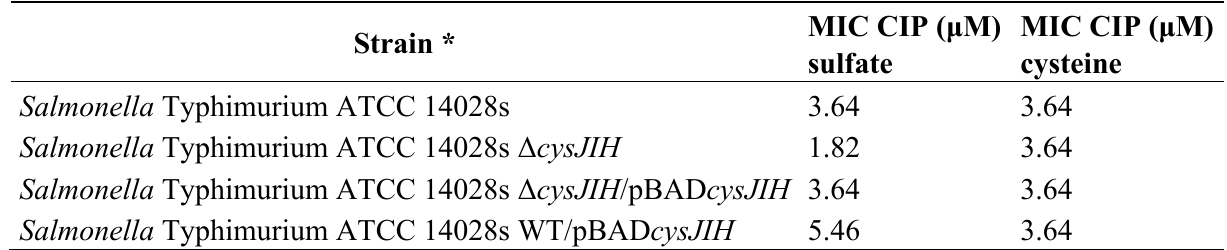
Table 1 . Minimal Inhibitory Concentration (MIC) determination of strains used in this